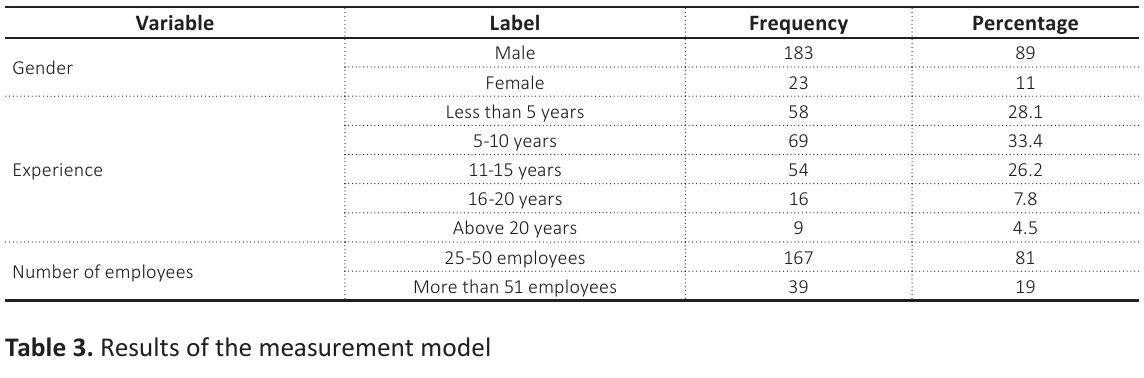
Table 2. Profile of the respondents